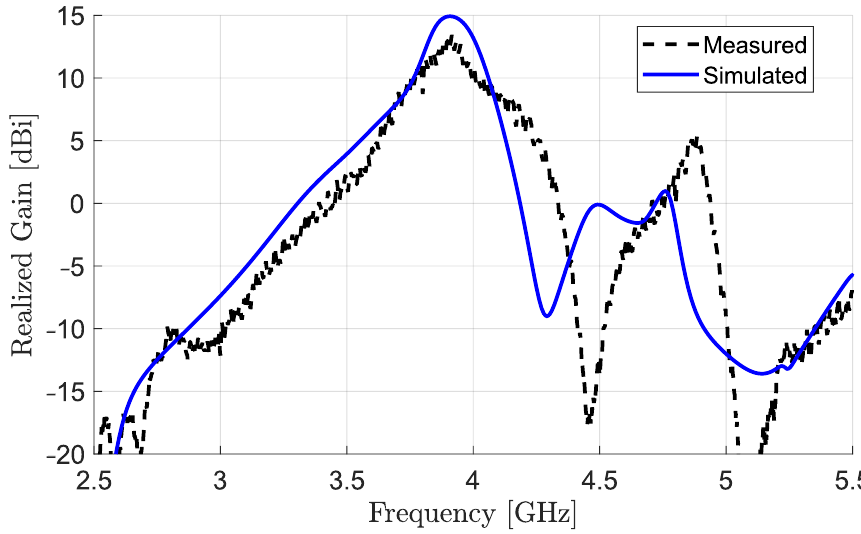
Figure 12. Simulated and measured realized gain of four-element standing-wave DRA array. To see the effect of such changes in the dielectric constant, the array was resimulated using the new estimated dielectric constant. The resimulated and measured gain and radiation patterns were in excellent agreement, as shown in Figure 14.